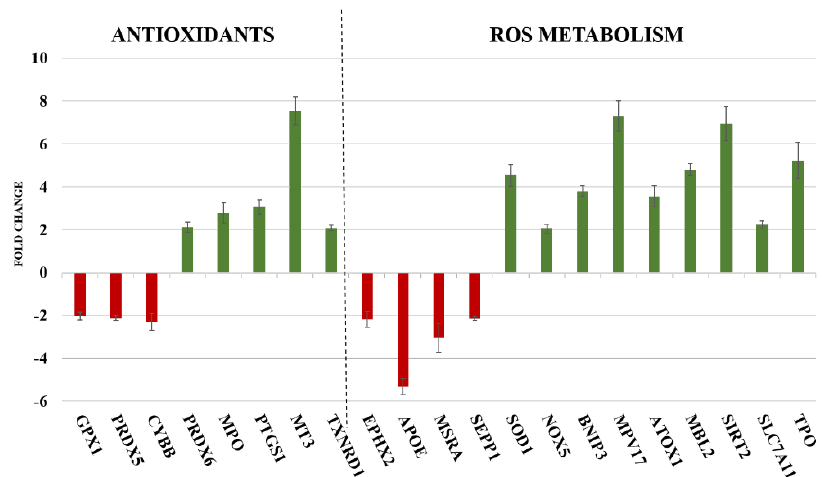
Figure 2. Up− and down−regulation of genes after DPPH treatment (1250 µM for 2 h) on PNT2 cells. Gene expression was evaluated on RNA extracted from three different biological replicates; histograms and error bars represent mean ± SD. Expression values greater or lower than ± 2.00 fold change were considered significant. Genes were graphically divided into two groups: genes with a key role in endogenous antioxidant mechanisms (left panel); genes encoding for proteins involved in Reactive Oxygen Species (ROS) metabolism (right panel).